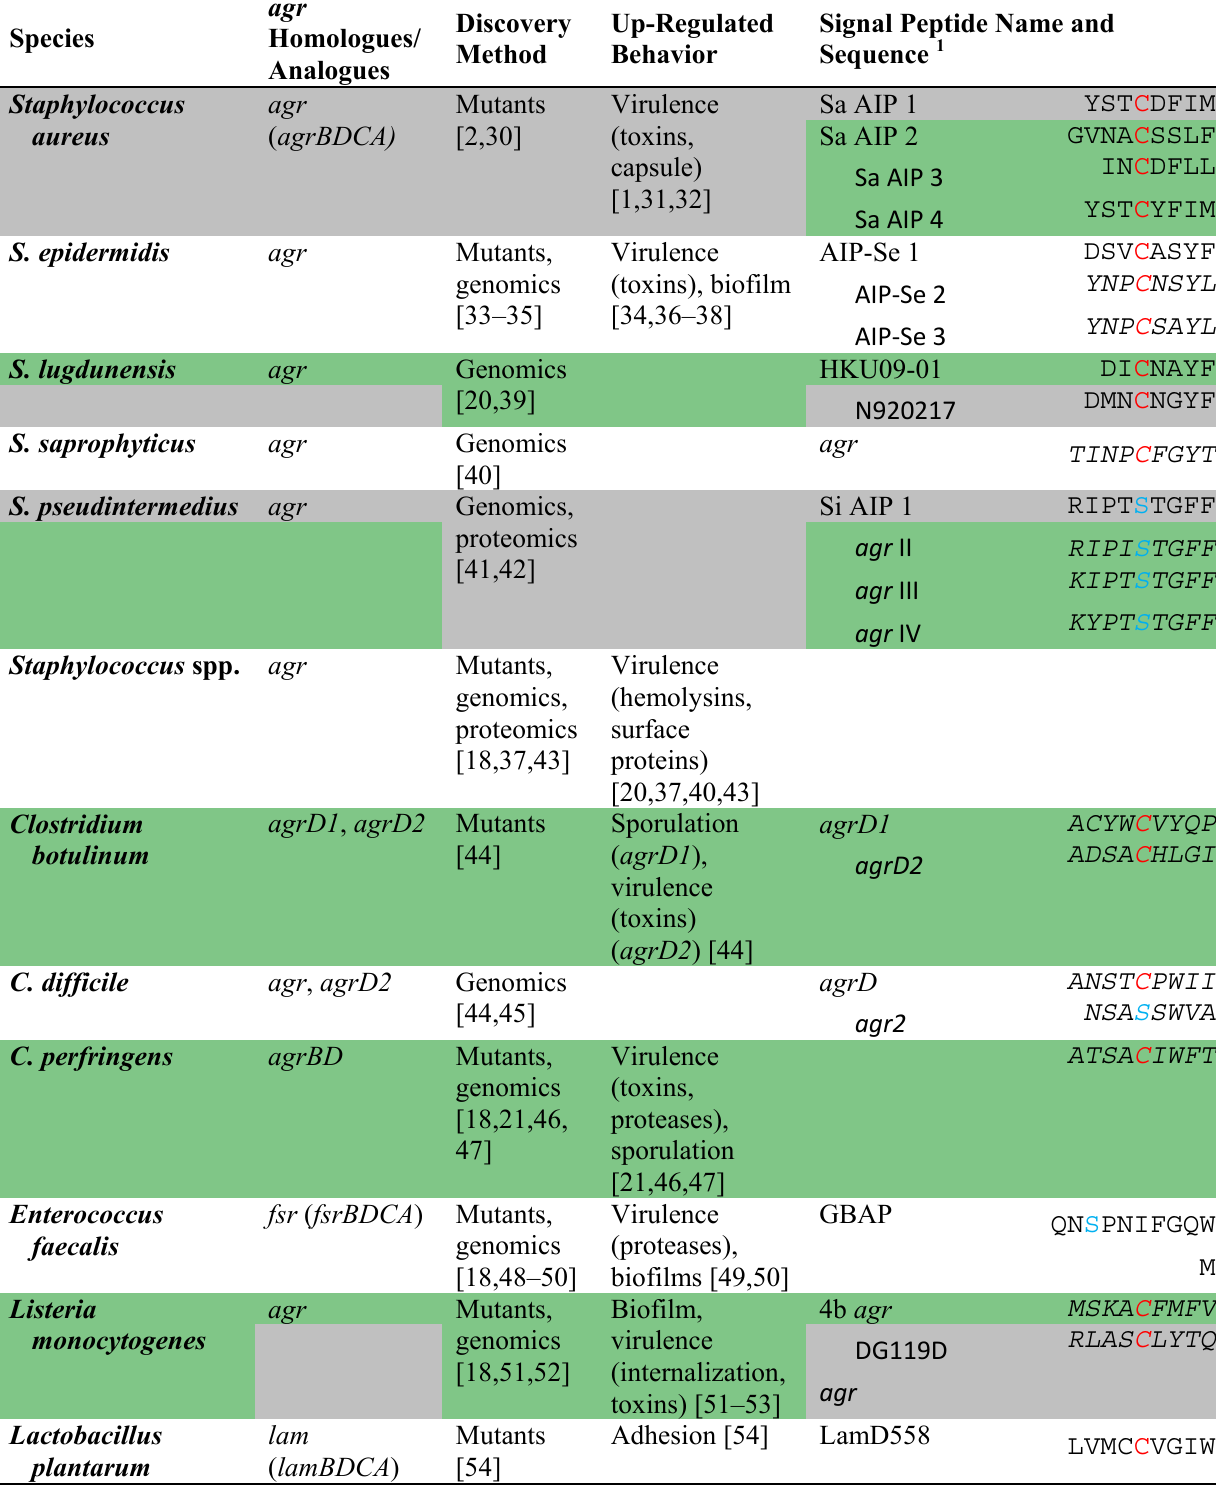
Table 1. agr homologues, analogues, and peptide pheromone systems in G+ pathogens, their effects on virulence, and their signal peptide sequences. Cysteines and serines in color highlight the residues required for thiolactone and lactone ring formation. Gray and white banding is to highlight individual